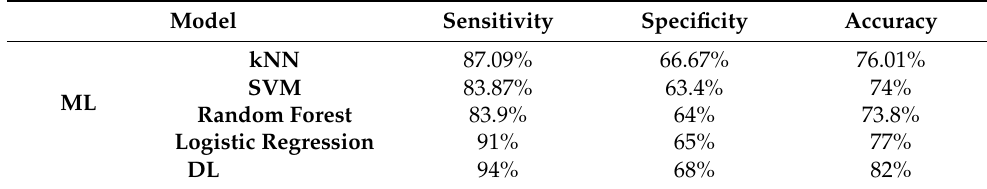
Table 2. Comparative table of ML and DL